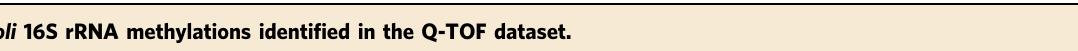
Table 3 E. coli 16S rRNA methylations identi fi ed in the Q-TOF dataset. Mod